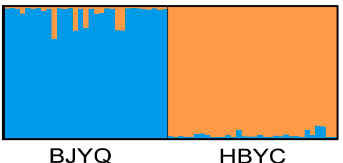
Figure 2. Population structure of K = 2 inferred by Bayesian clustering approaches based on 35 microsatellite markers. BJYQ: population of Yanqing from Beijing; HBYC: population of Yichang from Hubei province.